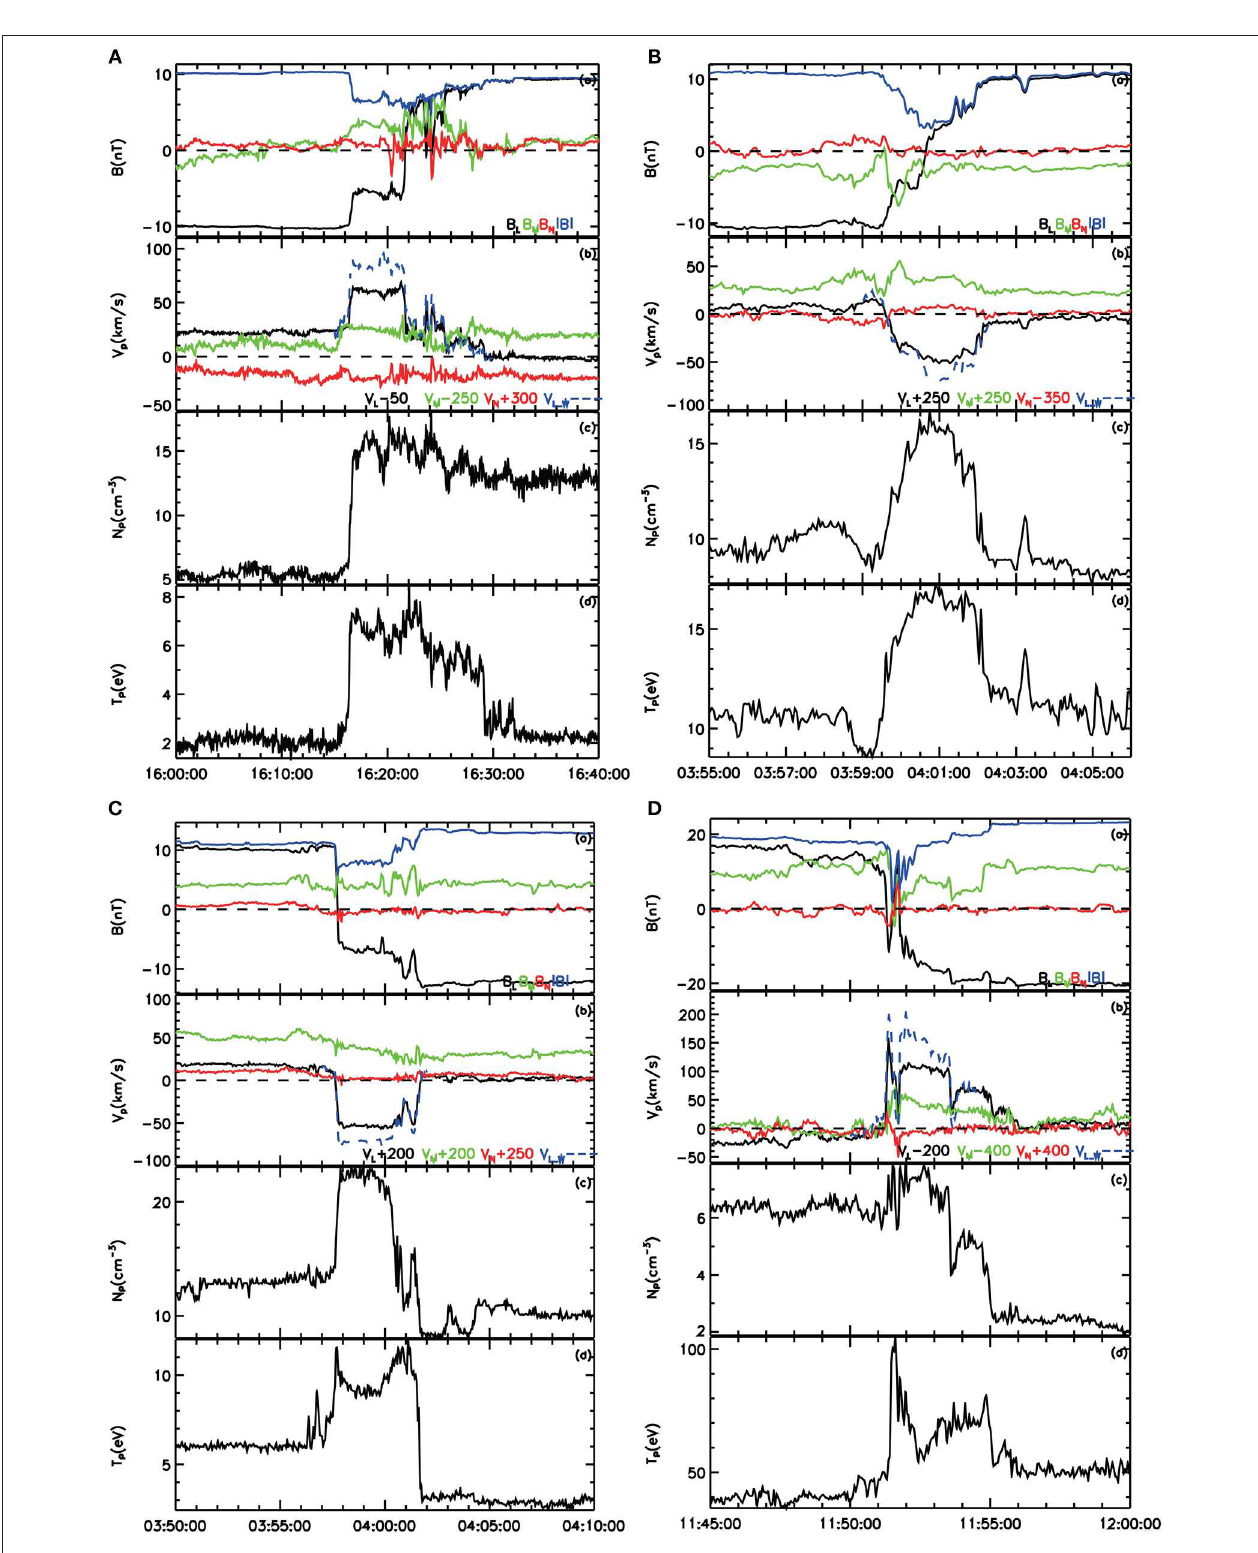
FIGURE 4 | The reconnection current sheet intermediating the coalescence of flux ropes in ICME (A–D) . For each case, the figure format is similar to Figure 2 .